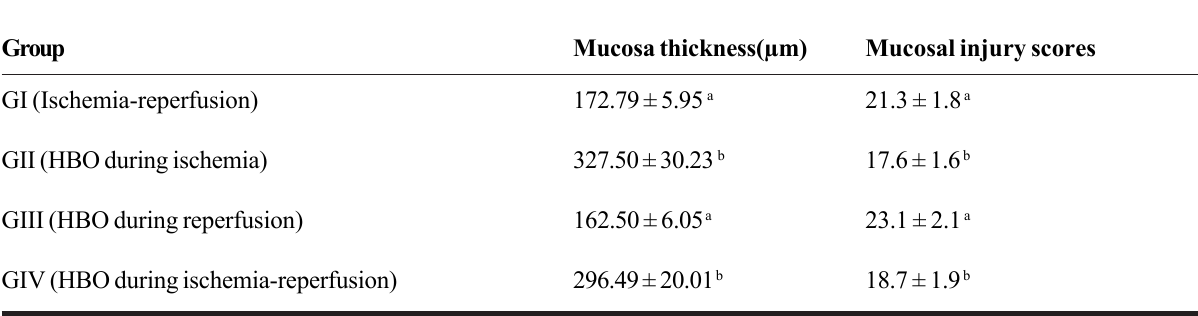
TABLE 1 – Mucosal thickness and histological scores of the ischemic injury imposed to the small bowel mucosa. Values are given as mean ±